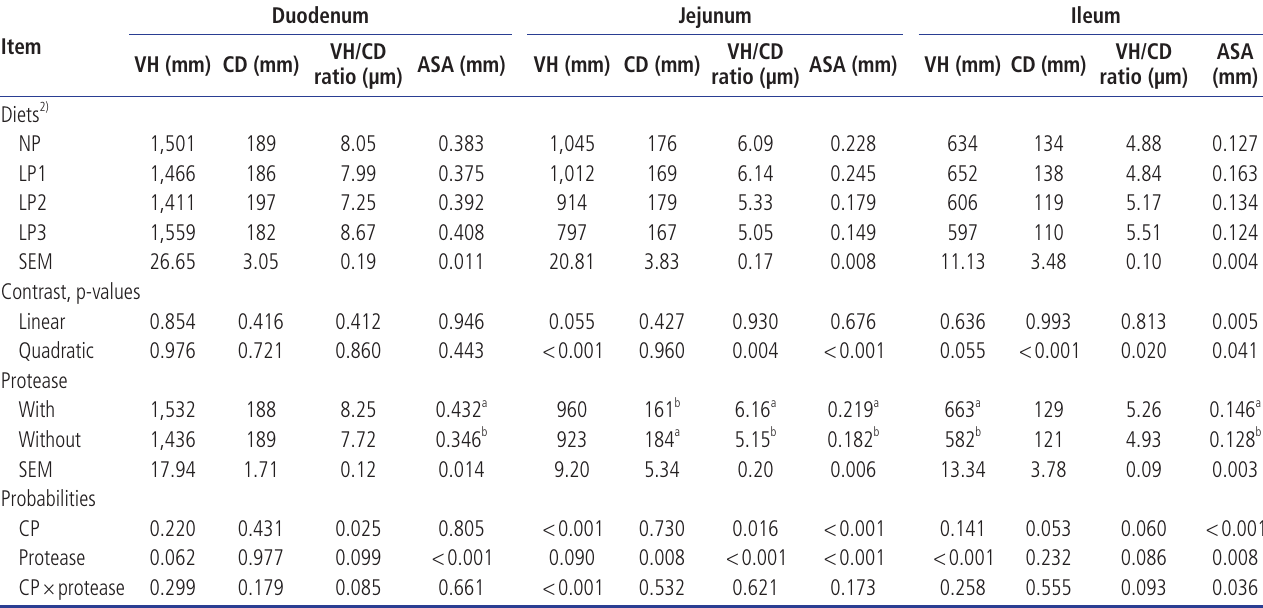
Table 6. Effect of crude protein level and protease enzyme supplementation on small intestinal morphology in broiler chickens at 35 days of age 1)